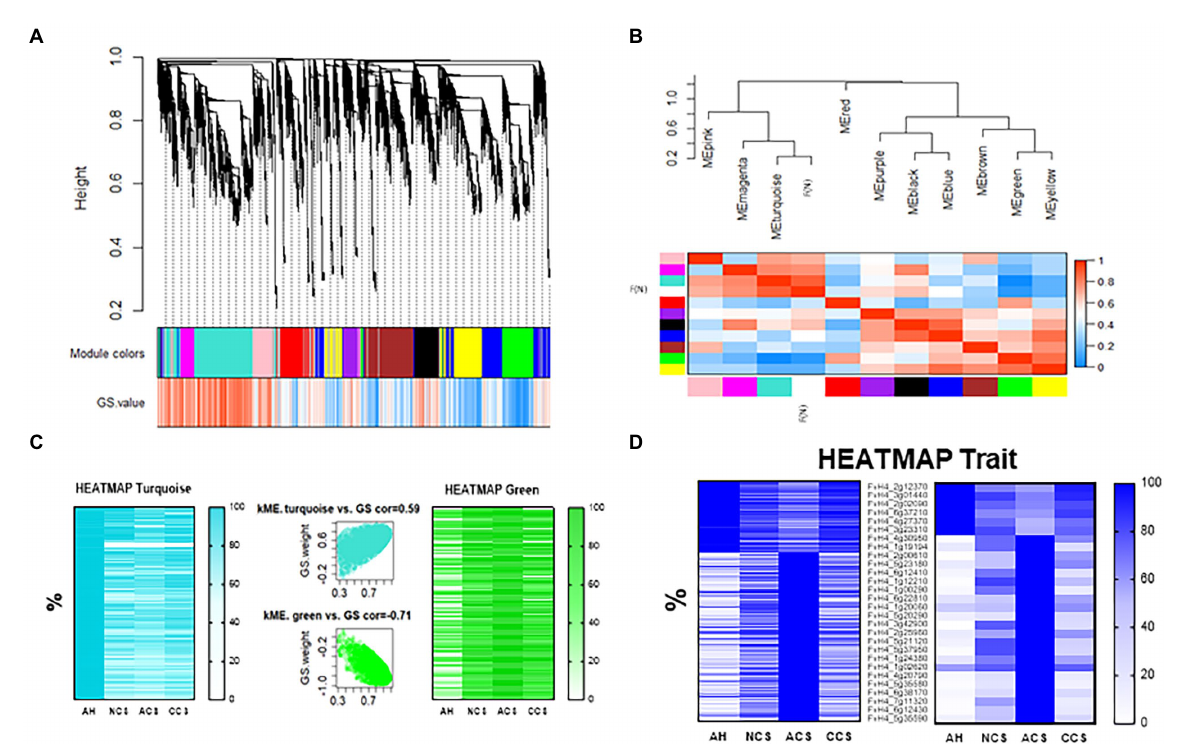
FIGURE 9 Weighted Gene Correlation Network Analysis. (A) Gene cluster dendrogram and module colors assignment for detection of the modules together with the gene significance for body weight (GS. Weight). Colors in the horizontal bar represent the modules. Ten modules with 31,000 transcripts were detected with WGCNA. (B) Eigengene dendrogram with an adjacency heatmap for module-trait (shearing average force, F(N)) relationship, the progressively intensity gradient of blue and red colors are indicating a high co-expression interconnectedness. (C) Module colors heatmap representing Reads Per Kilobase Million (RPKM) expressed as a relative percentage of genes obtained in turquoise (left) and green (right) modules. In the middle is shown the modules significantly correlated with F(N): module membership (MM) turquoise (middle-up) and green (middle-down) vs. GS. Weight. Each point represented an individual gene within each module, which were plotted by GS. Weight on the Y -axis and MM on the X -axis. (D) Heatmap showing the expression of the 910 genes (left) that mostly correlate with strawberry firmness ( − 0.85 ≥ kME ≥ 0.85), represented as a relative RPKM percentage of the genes correlated. On right a selection of 28 genes analyzed by